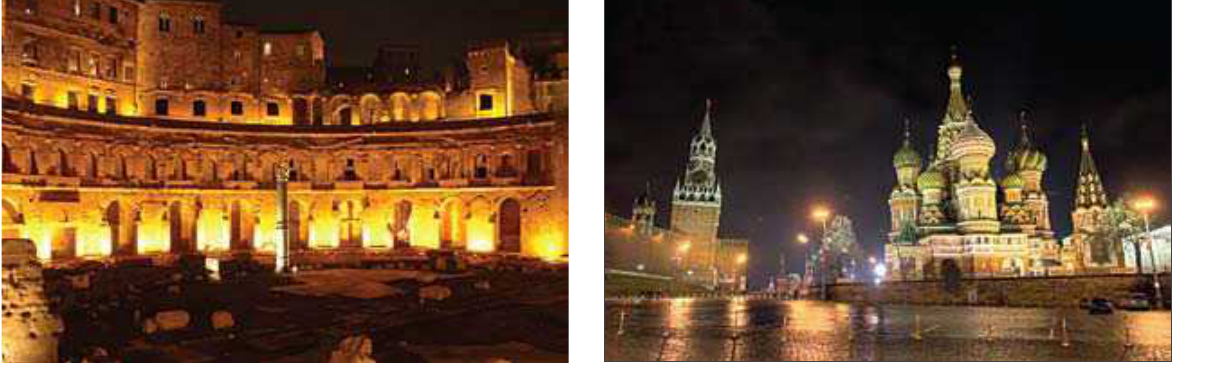
Fig. 6. Forum in rome, 2004 Fig. 7. red Square in Moscow, 2008